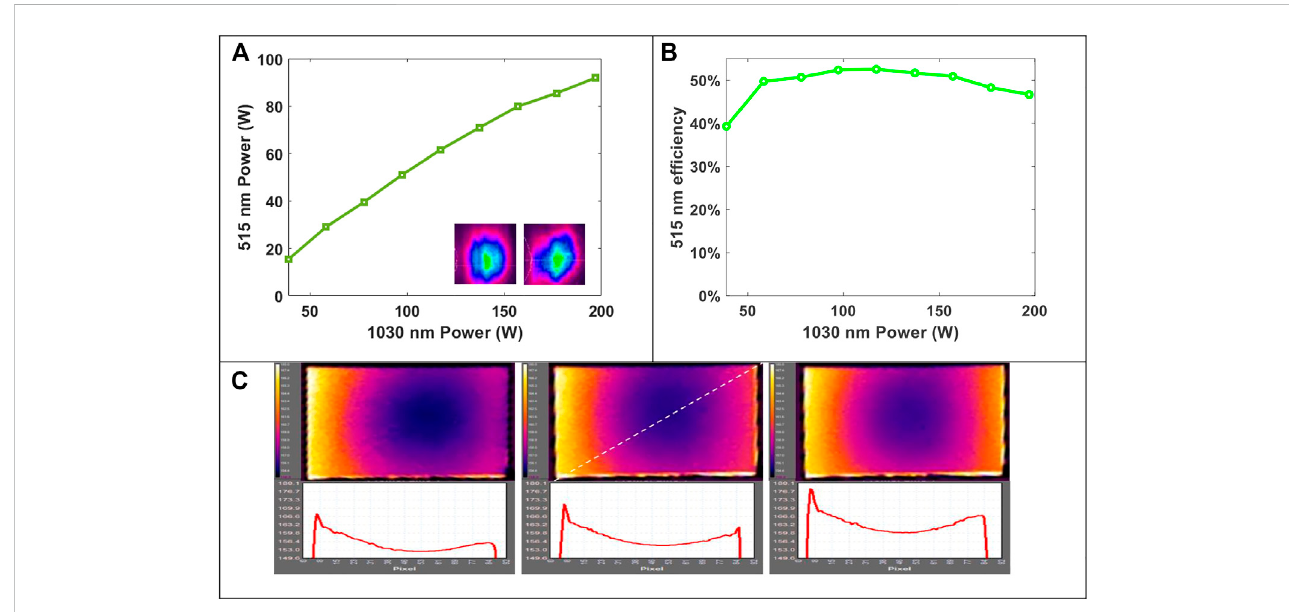
FIGURE 2 Laseraveragepower (A) andconversionef fi ciencyat515nm (B) versus the1-umpumplaseraveragepower.Insetshowsthe1,030-nm(left)and515-nm (right) beam pro fi les (not-to-scale). (C) Temperature distribution of the LBO crystal entrance surface at (left to right) 0%, 50%, and 100% pump power. Inset under each photograph: temperature pro fi le along a diagonal line; temperature color range: 150 ° C – 180 °